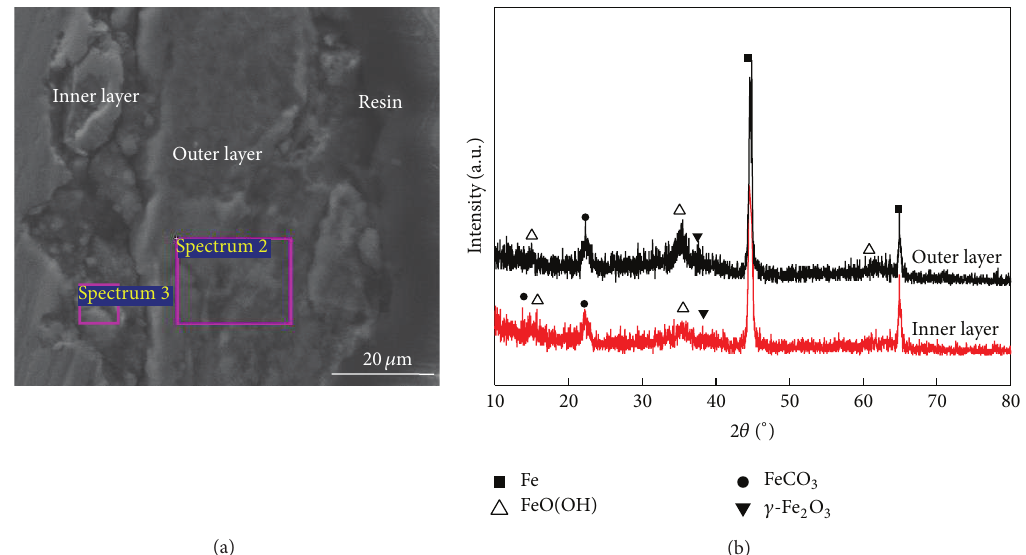
Figure 5: Sectional morphology (a) and XRD pattern (b) of corrosion product layers on X80 steel in red soil for 24 weeks.